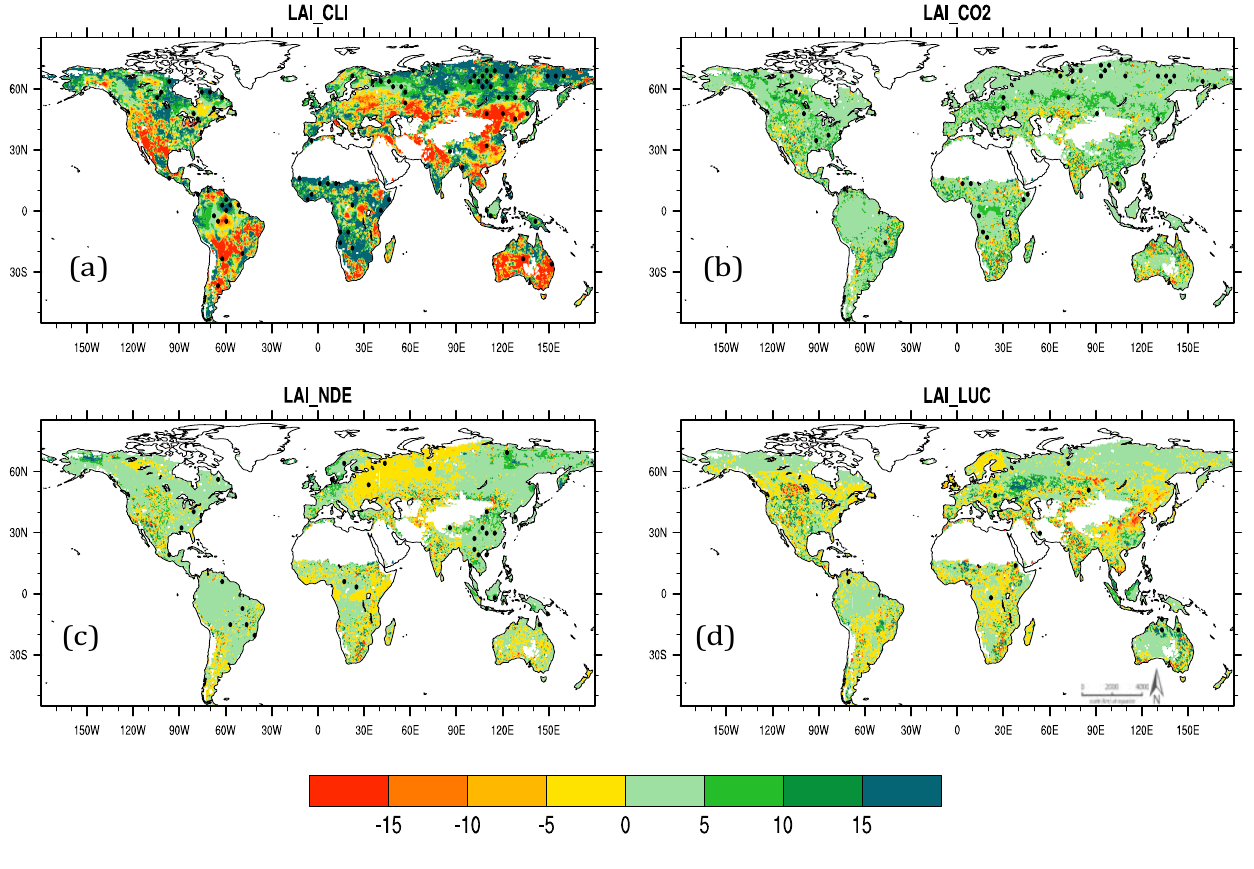
Figure 4. ( a – d ) Spatial distribution pattern of changes in simulated annual LAI (%/28 yrs) and ( e ) their dominant controlling factors from 1982 to 2009. (a) experiment